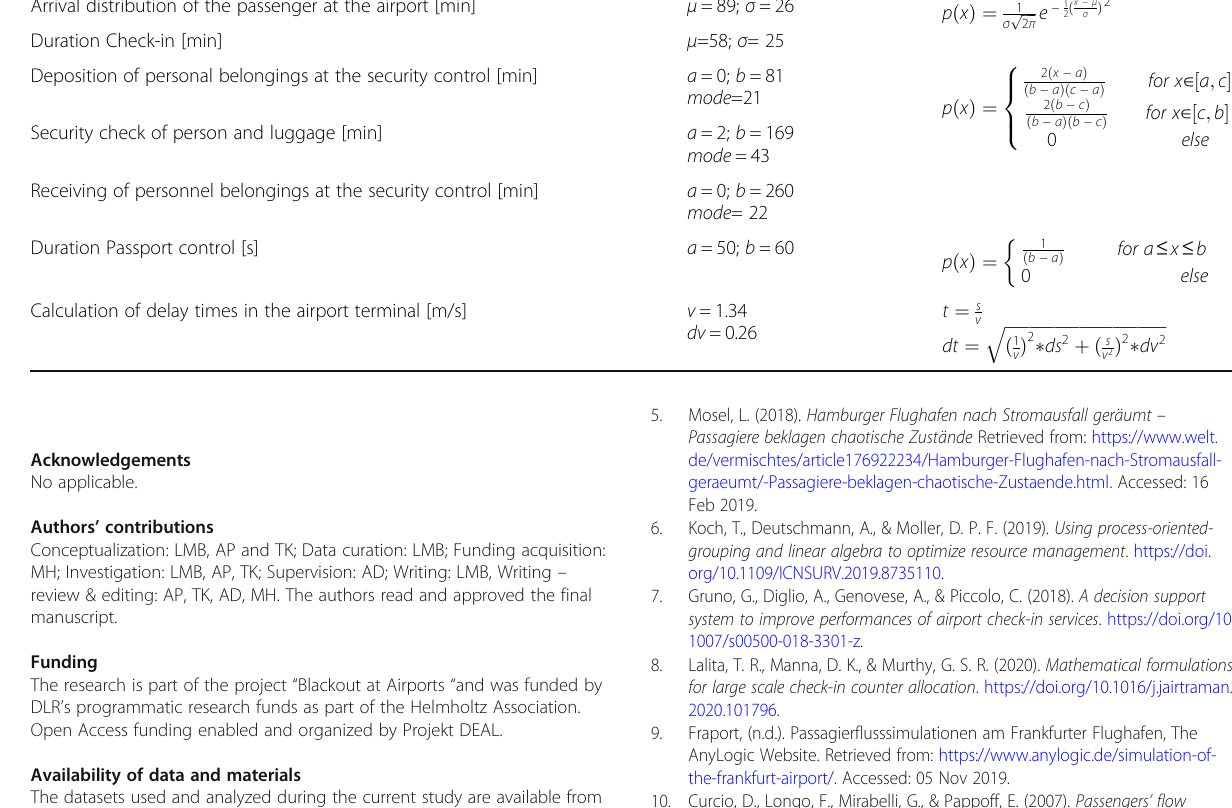
Table 4 Overview of the core equations used in the model Process Parameter Equation Arrival distribution of the passenger at the airport